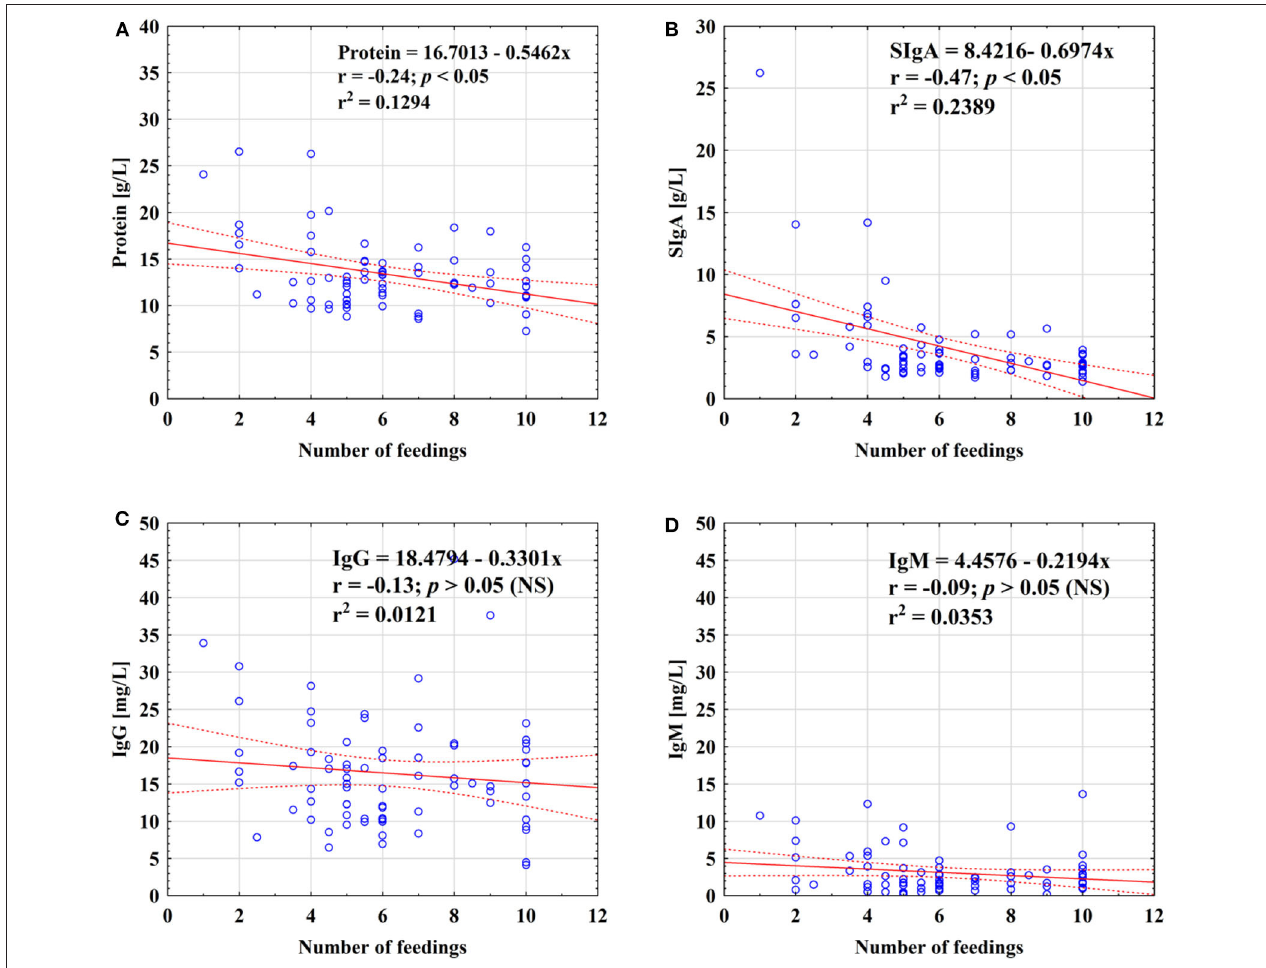
FIGURE 3 | Relationship between concentration of protein (A) , SIgA (B) , IgG (C) , and IgM (D) and the number of feedings of mother’s milk. A solid line indicates linear regression, and 95% confidence intervals are shown by dotted lines; blue circles refer to individual samples. NS, not